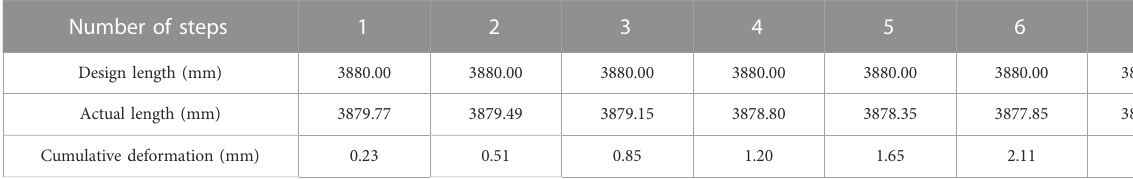
TABLE 8 Actual measured HPC deformation.